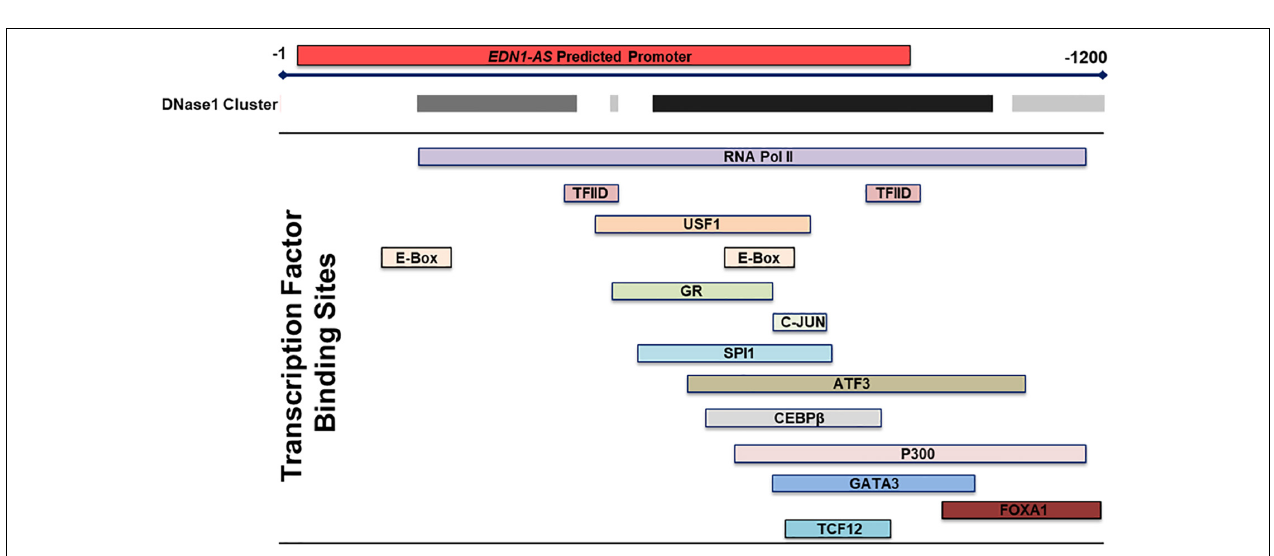
FIGURE 2 | Transcription Factor Binding Sites within the Predicted Promoter in the 3 (cid:48) UTR of EDN1 . Using the transcription factor binding sites track within the UCSC Genome Browser, multiple transcription factor binding sites were identified by ChIP within the 3 (cid:48) UTR EDN1 predicted promoter. Additionally, the DNase I cluster track showed multiple areas of high DNase sensitivity. The gray box indicates the extent of the hypersensitive region with darker boxes representing a stronger hypersensitivity signal. These data taken together suggests that this predicted promoter region is transcriptionally regulated and that the chromatin is in an open